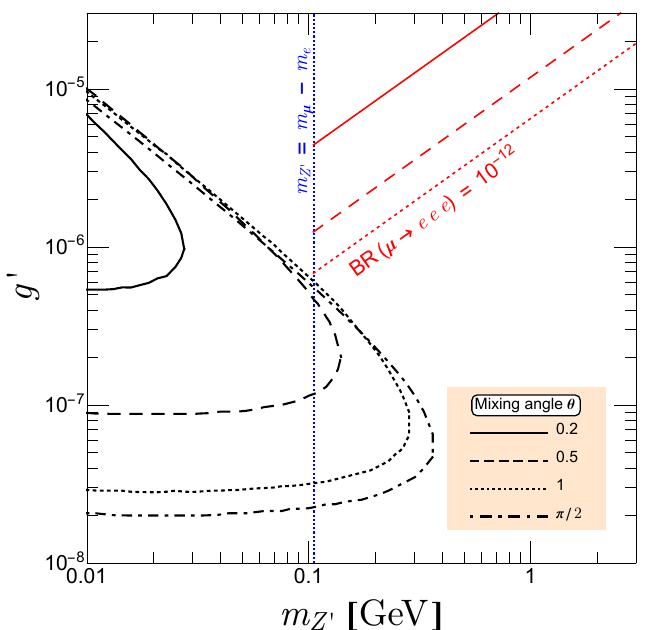
Figure 8 . The same plots as figure 6 for the vector interaction. The mixing angle is taken to 0 . 2 (solid), 0 . 5 (dashed), 1 (dotted), and π/ 2 (dot-dashed).